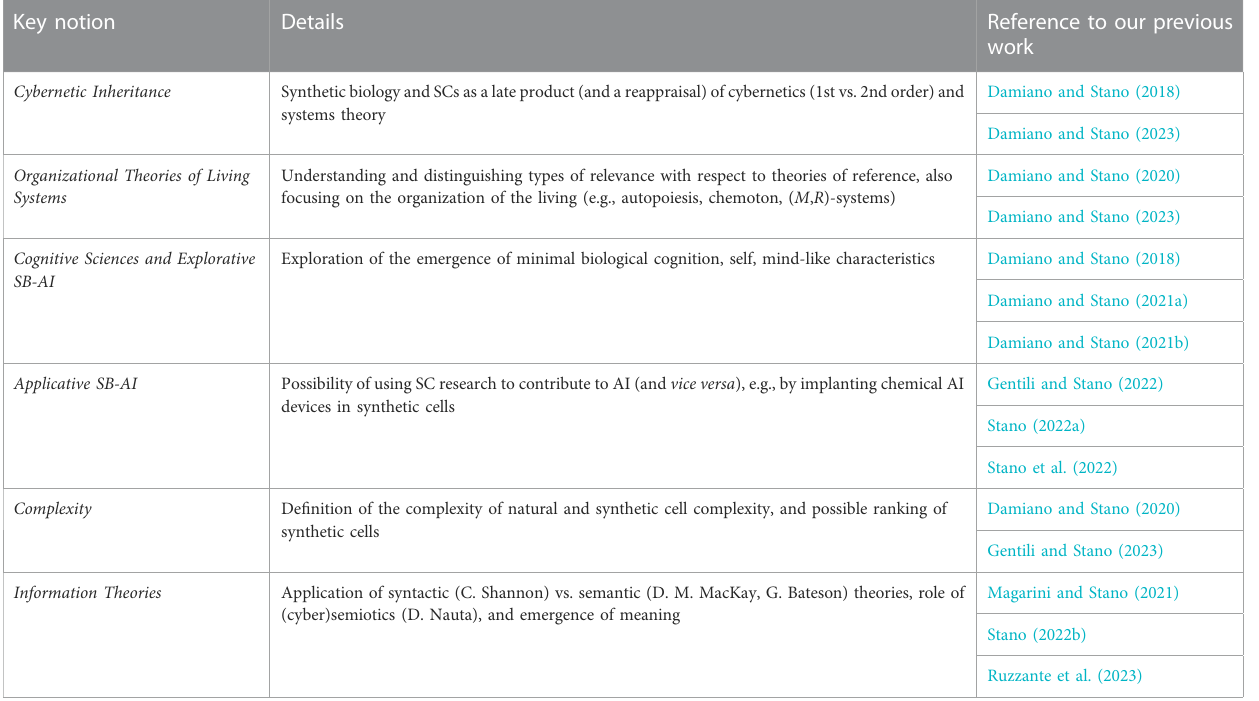
TABLE 1 List of theoretical and epistemological SC-related issues currently investigated by the authors. Key